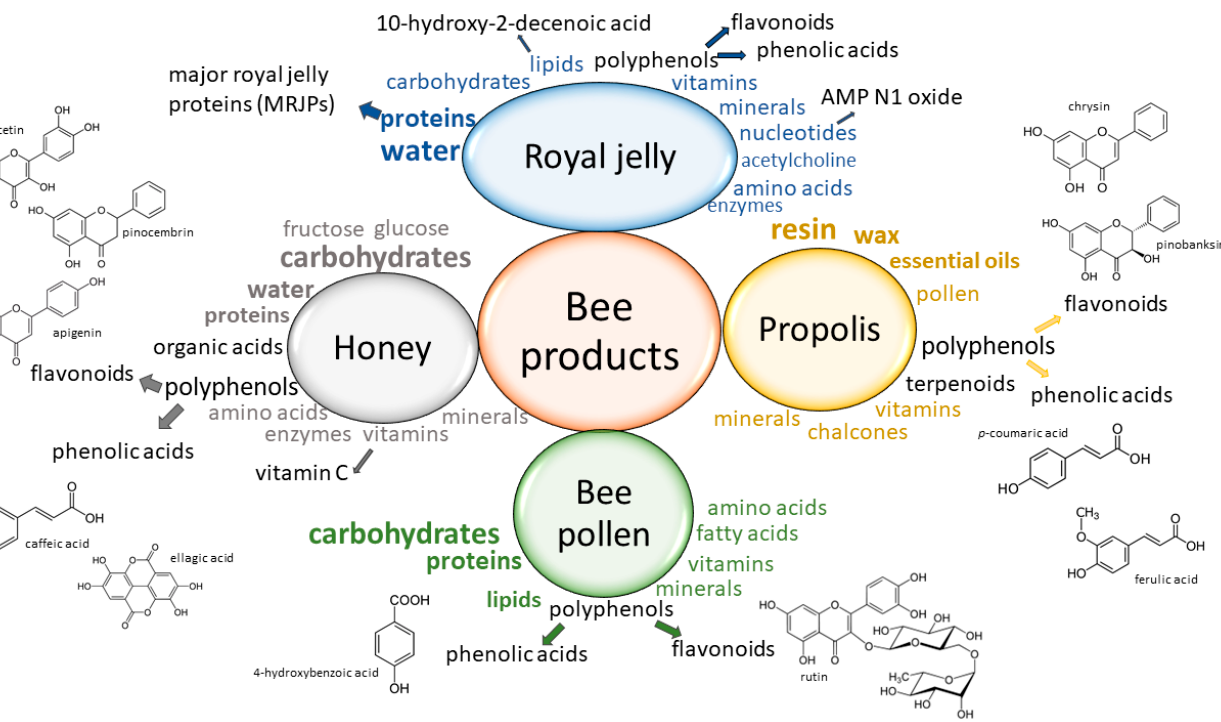
Figure 1. The chemical composition of bee products with emphasis on the main compounds (depicted in black font letters) responsible for the antimicrobial, anti-inflammatory and/or antioxidant activity of bee products. Examples of phenolic acids and flavonoids chemical structures in bee products are presented left and right accordingly [3,16,39,40].